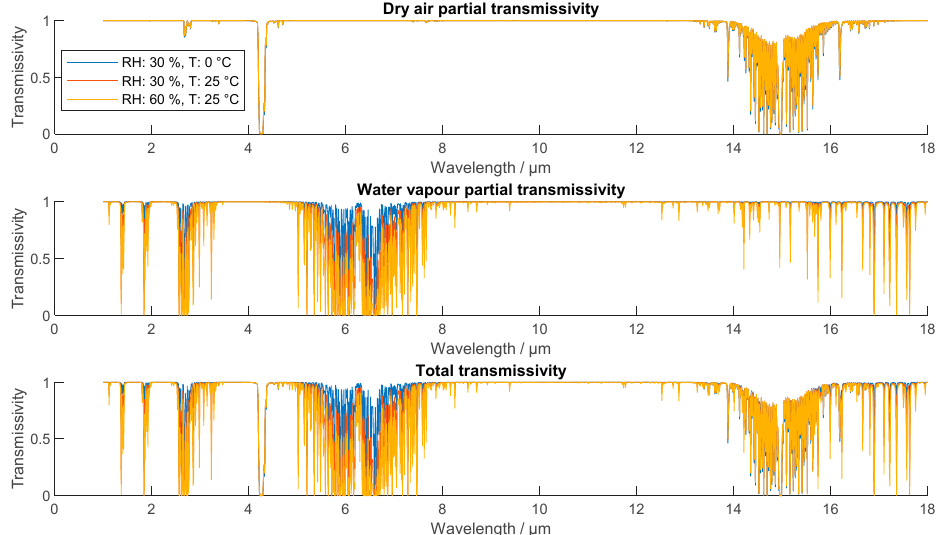
Figure 4. Spectral transmissivity of dry air, water vapour and combination of both from author’s previous publication [28]. Displayed spectra correspond to 1013.25 hPa atmospheric pressure and 10 m atmospheric path, calculated at 0.01 µm resolution.